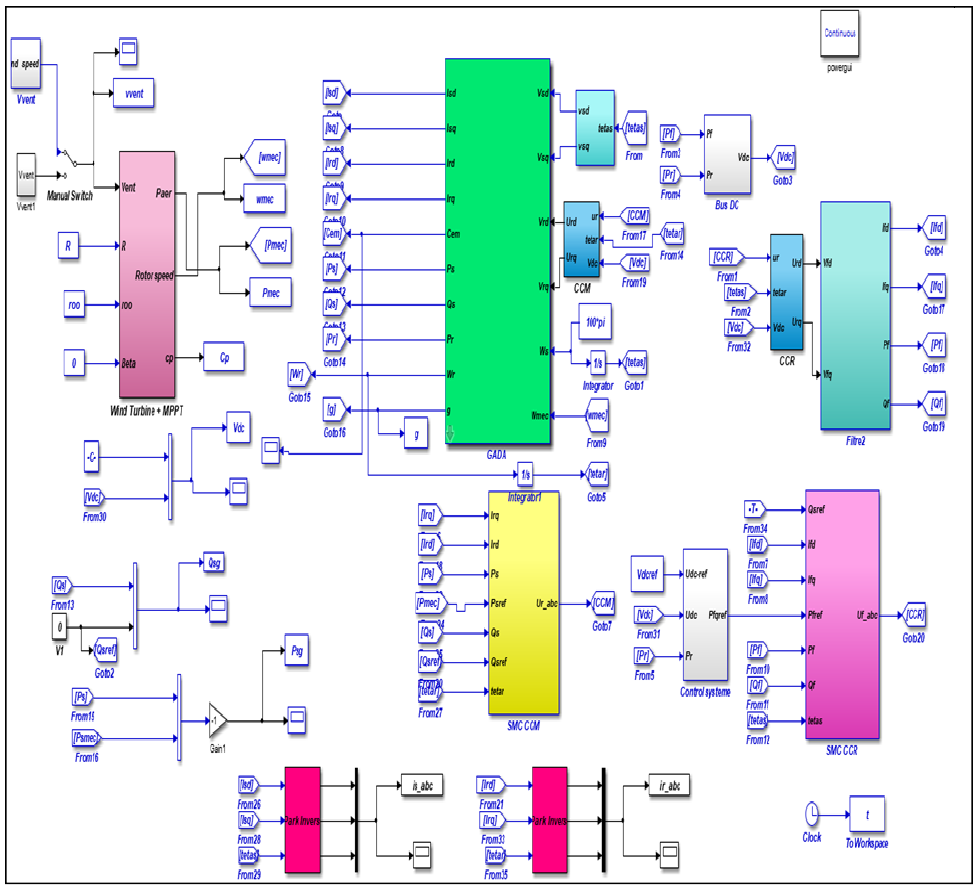
Figure 2. SMC control for wind